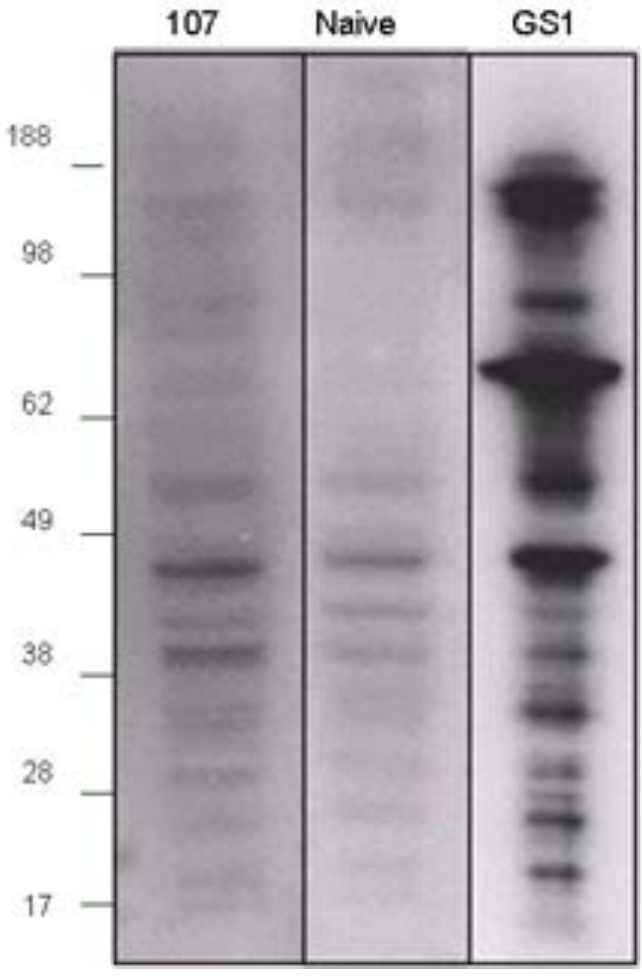
Figure 4. Serum IgM antibodies and GS-I binding to 4T1 cell lysate. Whole-cell lysate from 4T1 cell line was prepared. Mice (5/group) were pre-bled and immunized